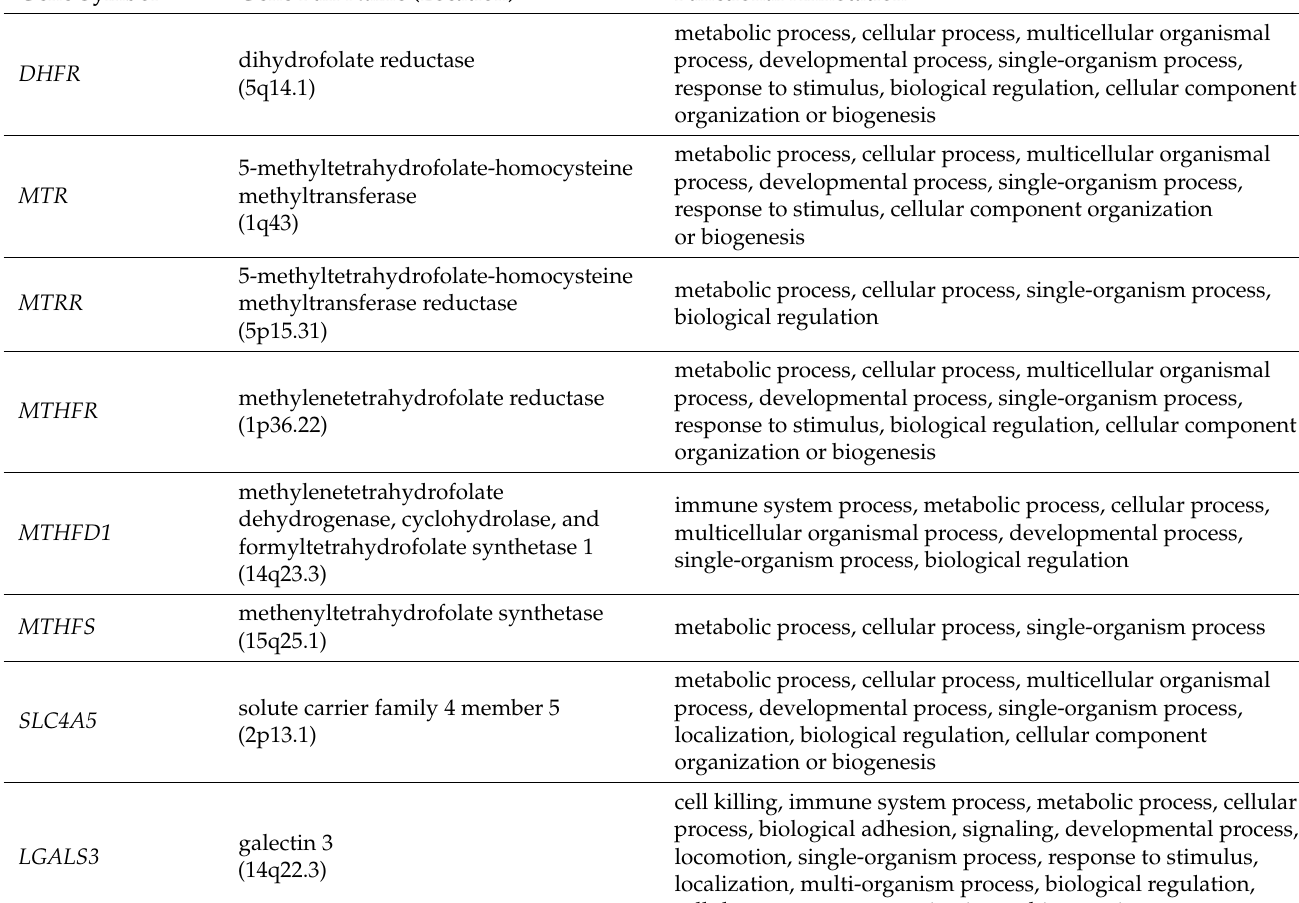
Table 2. List and information of the target